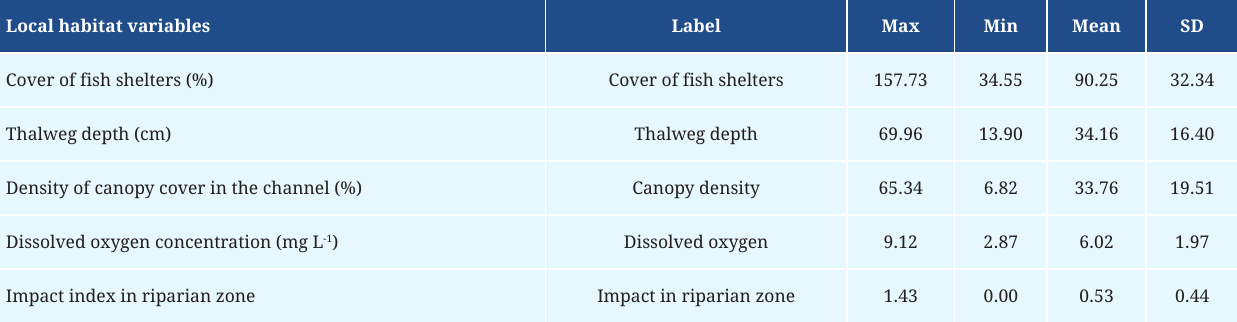
TABLE 2 | Local habitat variables of streams sampled in this study (Capim River basin, Eastern Amazon, Brazil). The table columns represent: Label = habitat variable code; Max = Maximum value; Min = Minimum value; Mean = mean value; SD = standard deviation. Local habitat